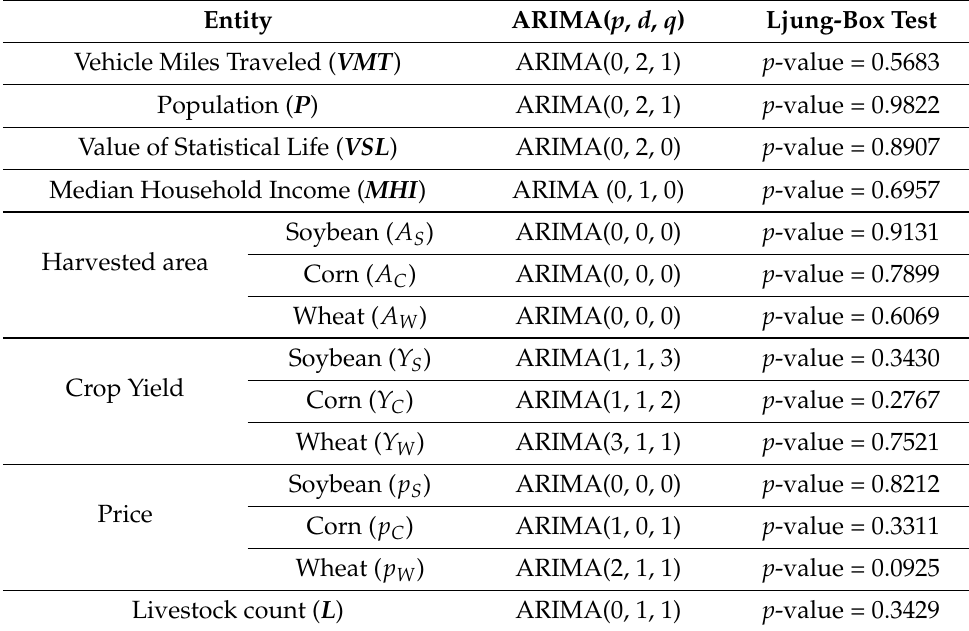
Figure 2. Logical flowchart for the ARIMA model. Table 1. Summary of forecasted variables using the ARIMA